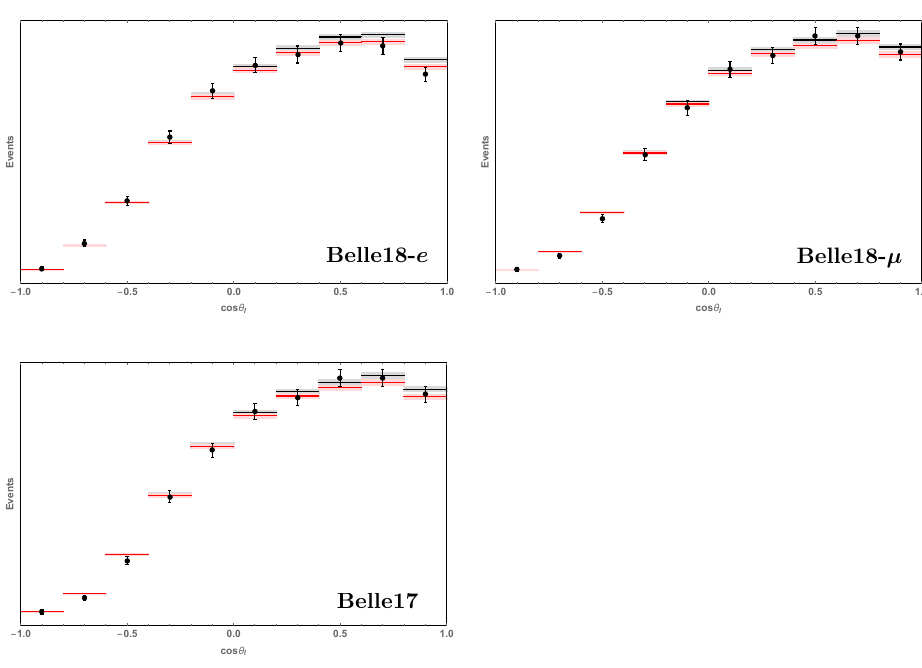
Figure 4 . Binned decay distributions of cos (cid:18) ‘ . Conventions are the same as in (cid:12)gure 3.